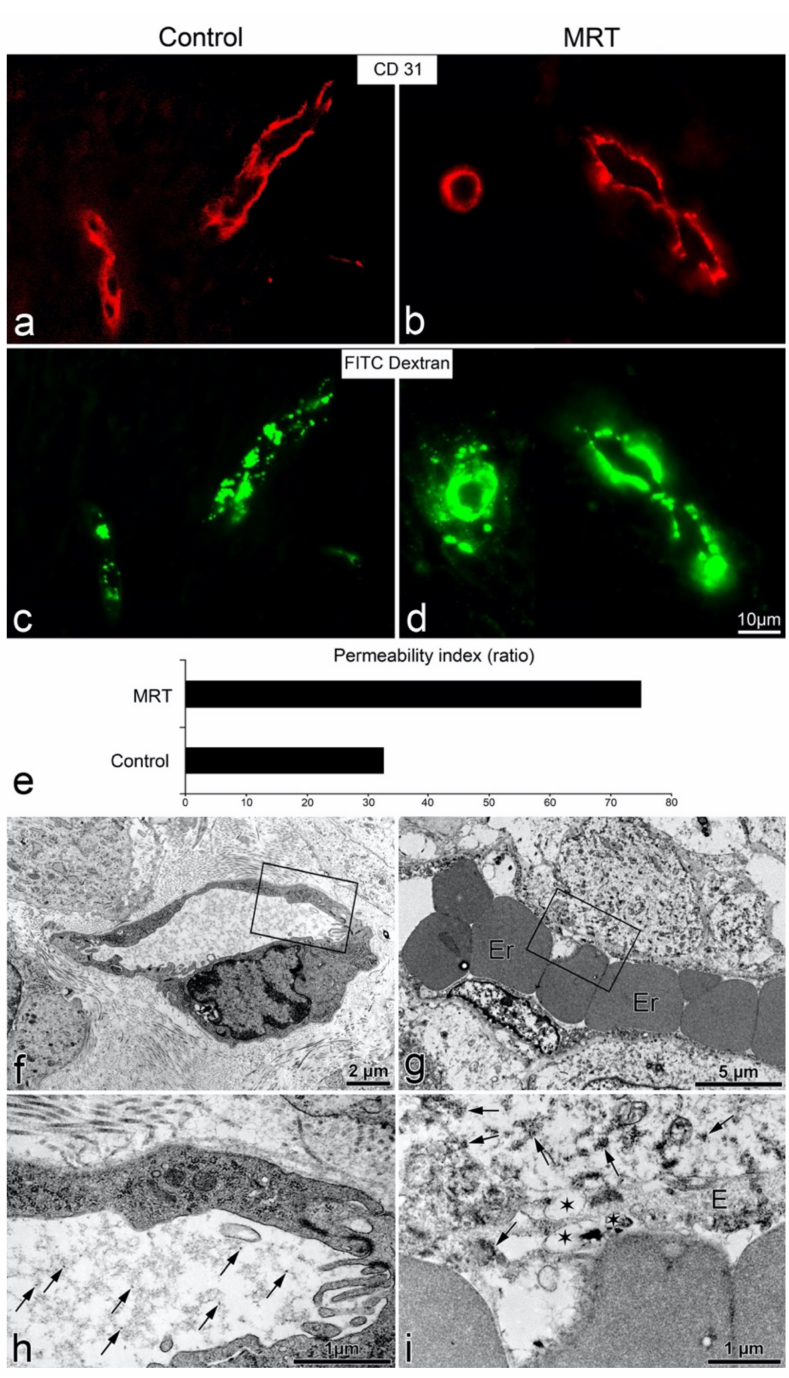
Figure 3. MRT-induced vascular permeability in mice harbouring the human U-87 glioblastoma xenograft. Fluorescence microscopy for CD31 and FITC-dextran in a control tumor ( a , c ); tumor post-MRT ( b , d ). There was no extravasation of the green FITC-dextran in the control tumor ( c ), while in the MRT-treated tumor ( d ), 45 min after 150 Gy, a bright halo of green fluorescence was visible. Image ( e ): graph showing the quantification of the vascular permeability in controls and MRT-treated tumors as the ratio of extravasated FITC-dextran fluorescent area/vessel area. The ultrastructure of tumor vessels was normal in controls ( f , h ), with no extravasation of FITC-dextran (intraluminal dextran as dark dots indicated by arrows). Conversely, in treated tumors ( g , i ), an extravasated fluorescent probe material was observed as dark dots (arrows) in the extravascular space; the disrupted endothelium contained multiple vacuoles of different sizes, indicated by asterisks. Er = erythrocyte. Images ( h , i ) are higher magnifications of the rectangles in ( f , g ),